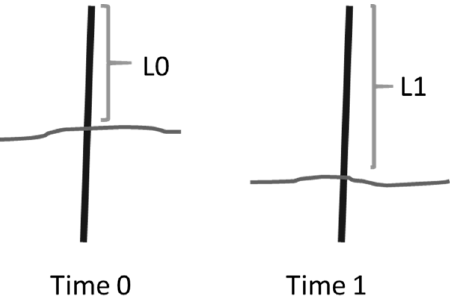
Figure 2. Erosion results in increased exposed length of erosion pins at Time 1 (L1), such that change in exposed length (L0–L1) is negative for erosion and positive for